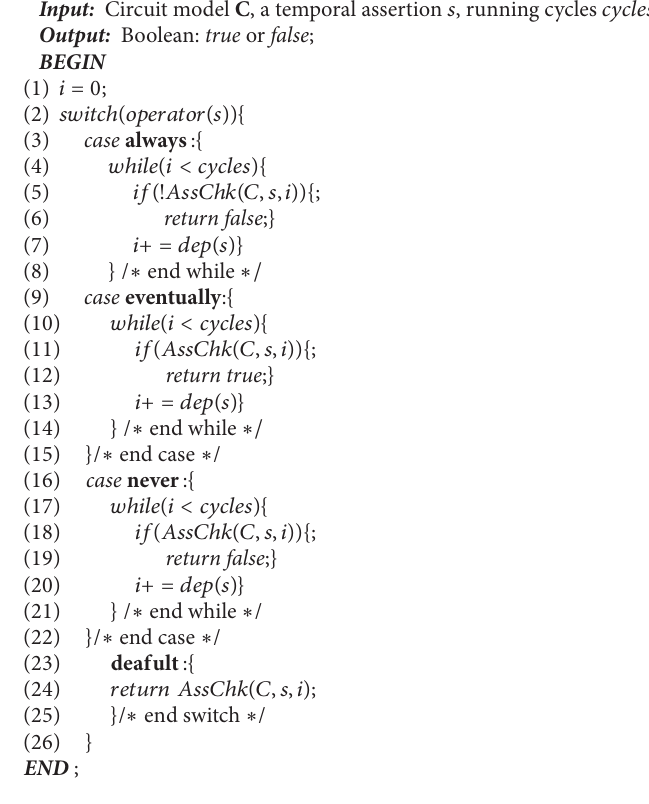
Algorithm 2: Assertion checking: 𝑇𝑒𝑚𝑝𝑜𝑟𝑎𝑙𝐴𝑠𝑠𝐶ℎ𝑘( C ,𝑠,𝑐𝑦𝑐𝑙𝑒𝑠) .